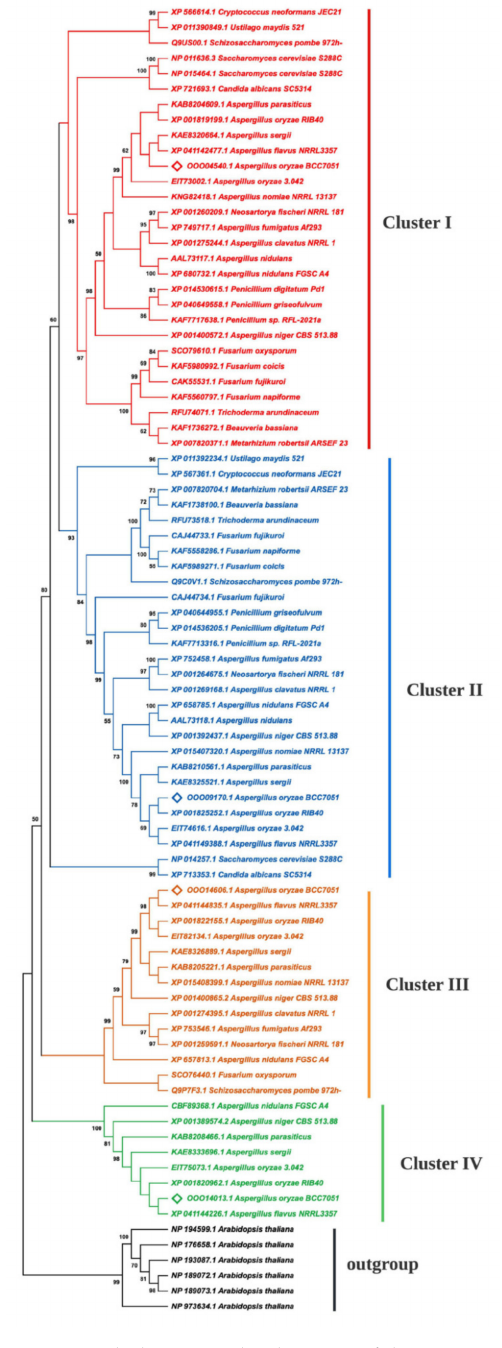
Figure 2. Phylogenetic dendrogram of the ammonium transporters of A. oryzae BCC 7051, yeasts, and fungi. The number over the nodes represents the bootstrap coefficient calculated from 500 replicates. Four AMT/MEP clusters, Cluster I, Cluster II, Cluster III, and Cluster IV, are highlighted in red, blue, orange, and green, respectively. ( ♦ ) indicates ammonium transporter sequence obtained from A. oryzae BCC 7051. The phylogenetic tree was constructed by the maximum-likelihood method using MEGA11